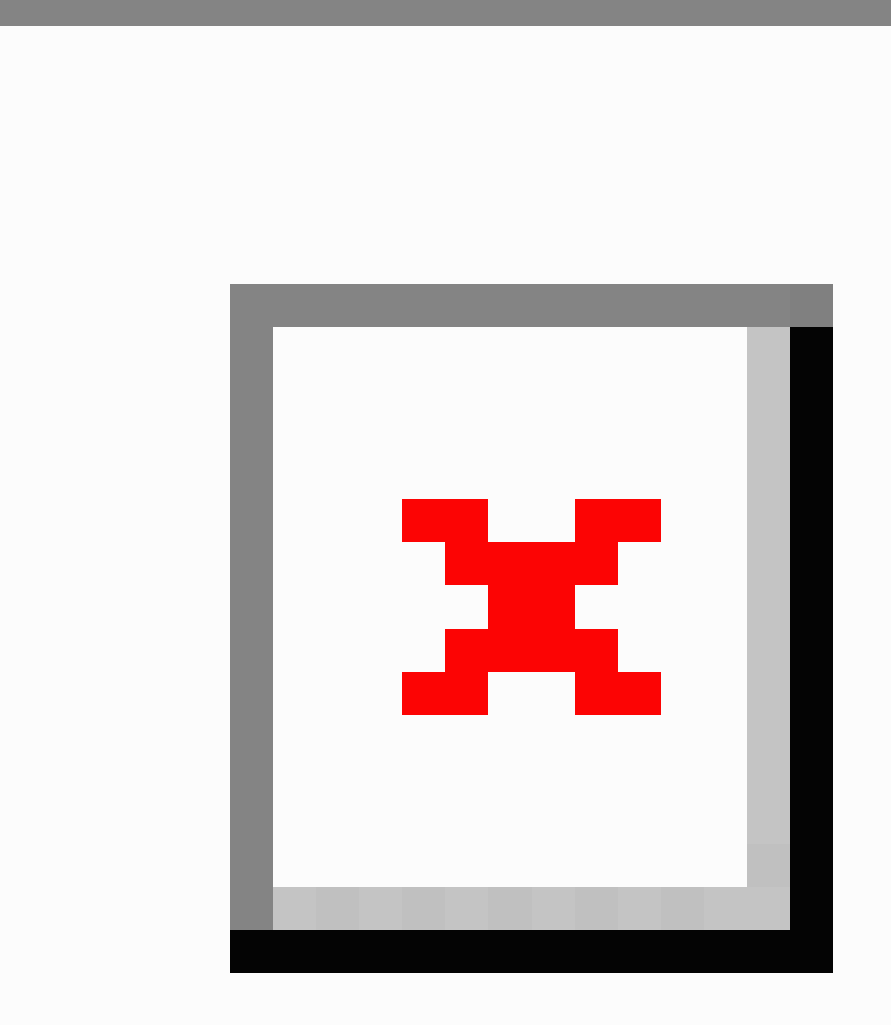
Figure 2. Shortage drug calcitriol injection advertised as an over-the-counter